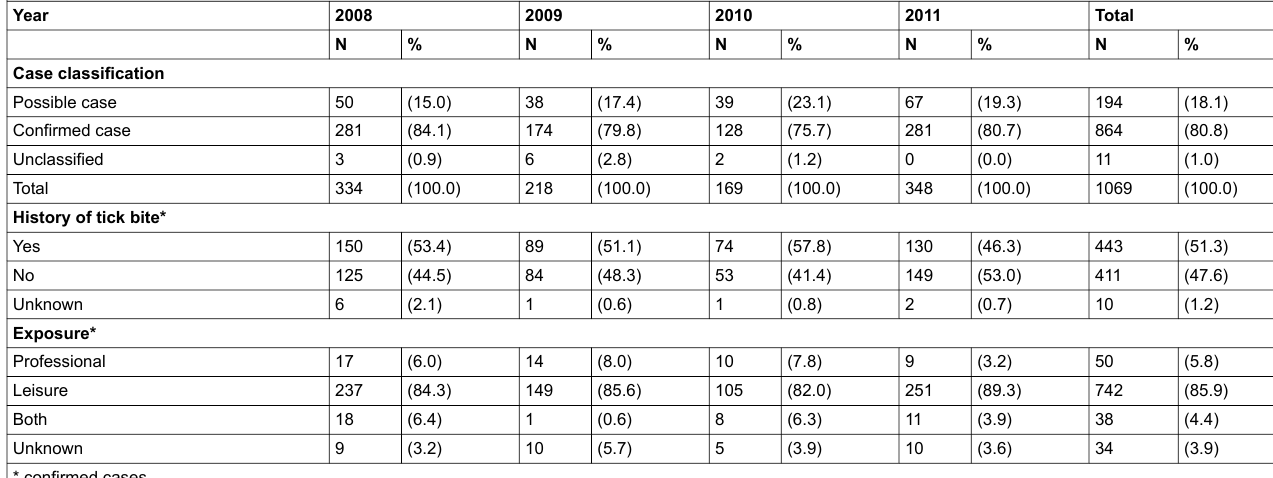
Table 2: Reports of Lyme borreliosis in Switzerland, 2008 to